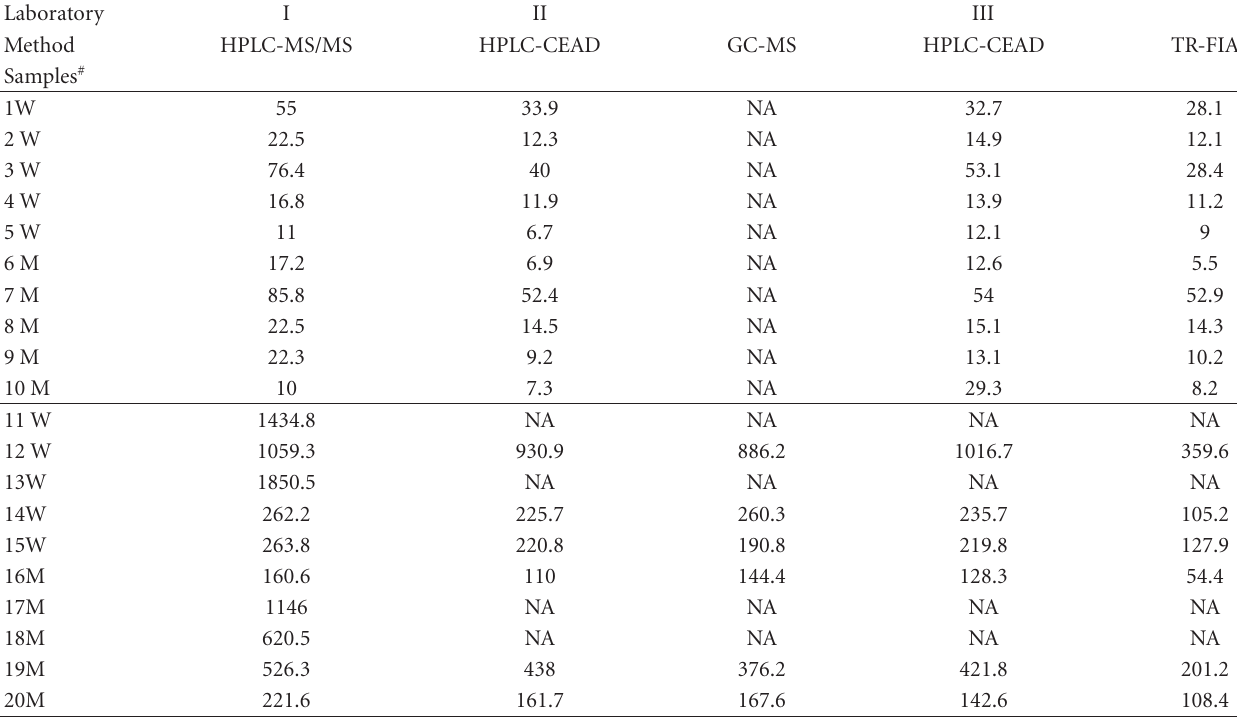
Table 2: Human serum EL concentrations (nM) before and after flaxseed ingestion measured by chromatographic and TRFIA methods.